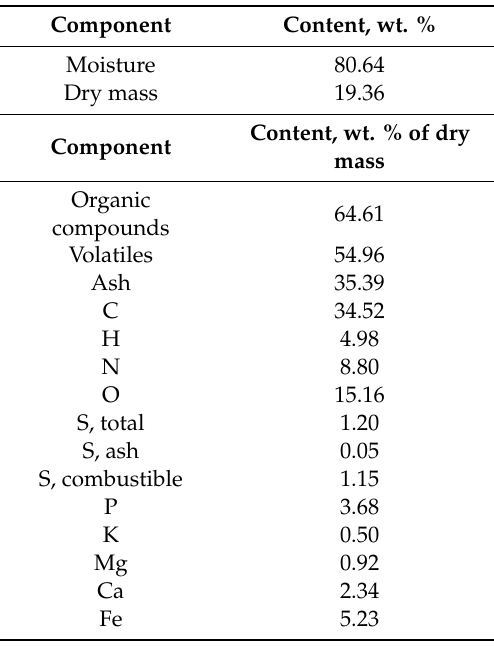
Table 1. Characteristics of sewage